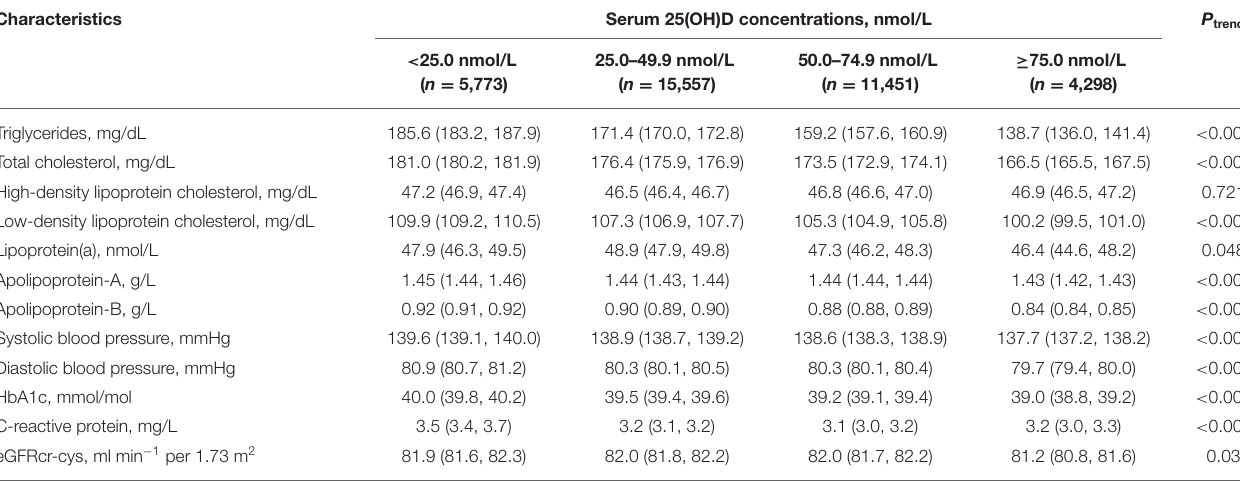
TABLE 2 | Adjusted means of cardiometabolic markers according to serum 25(OH)D concentrations among 37,079 CVD patients.